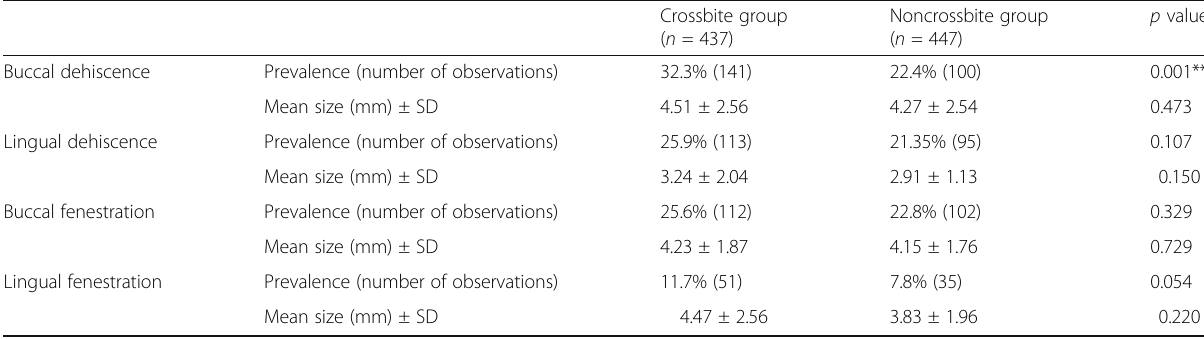
Table 6 Dehiscence and fenestration prevalence and mean size by buccal and lingual surfaces in the crossbite group (study group) and the noncrossbite group (comparison